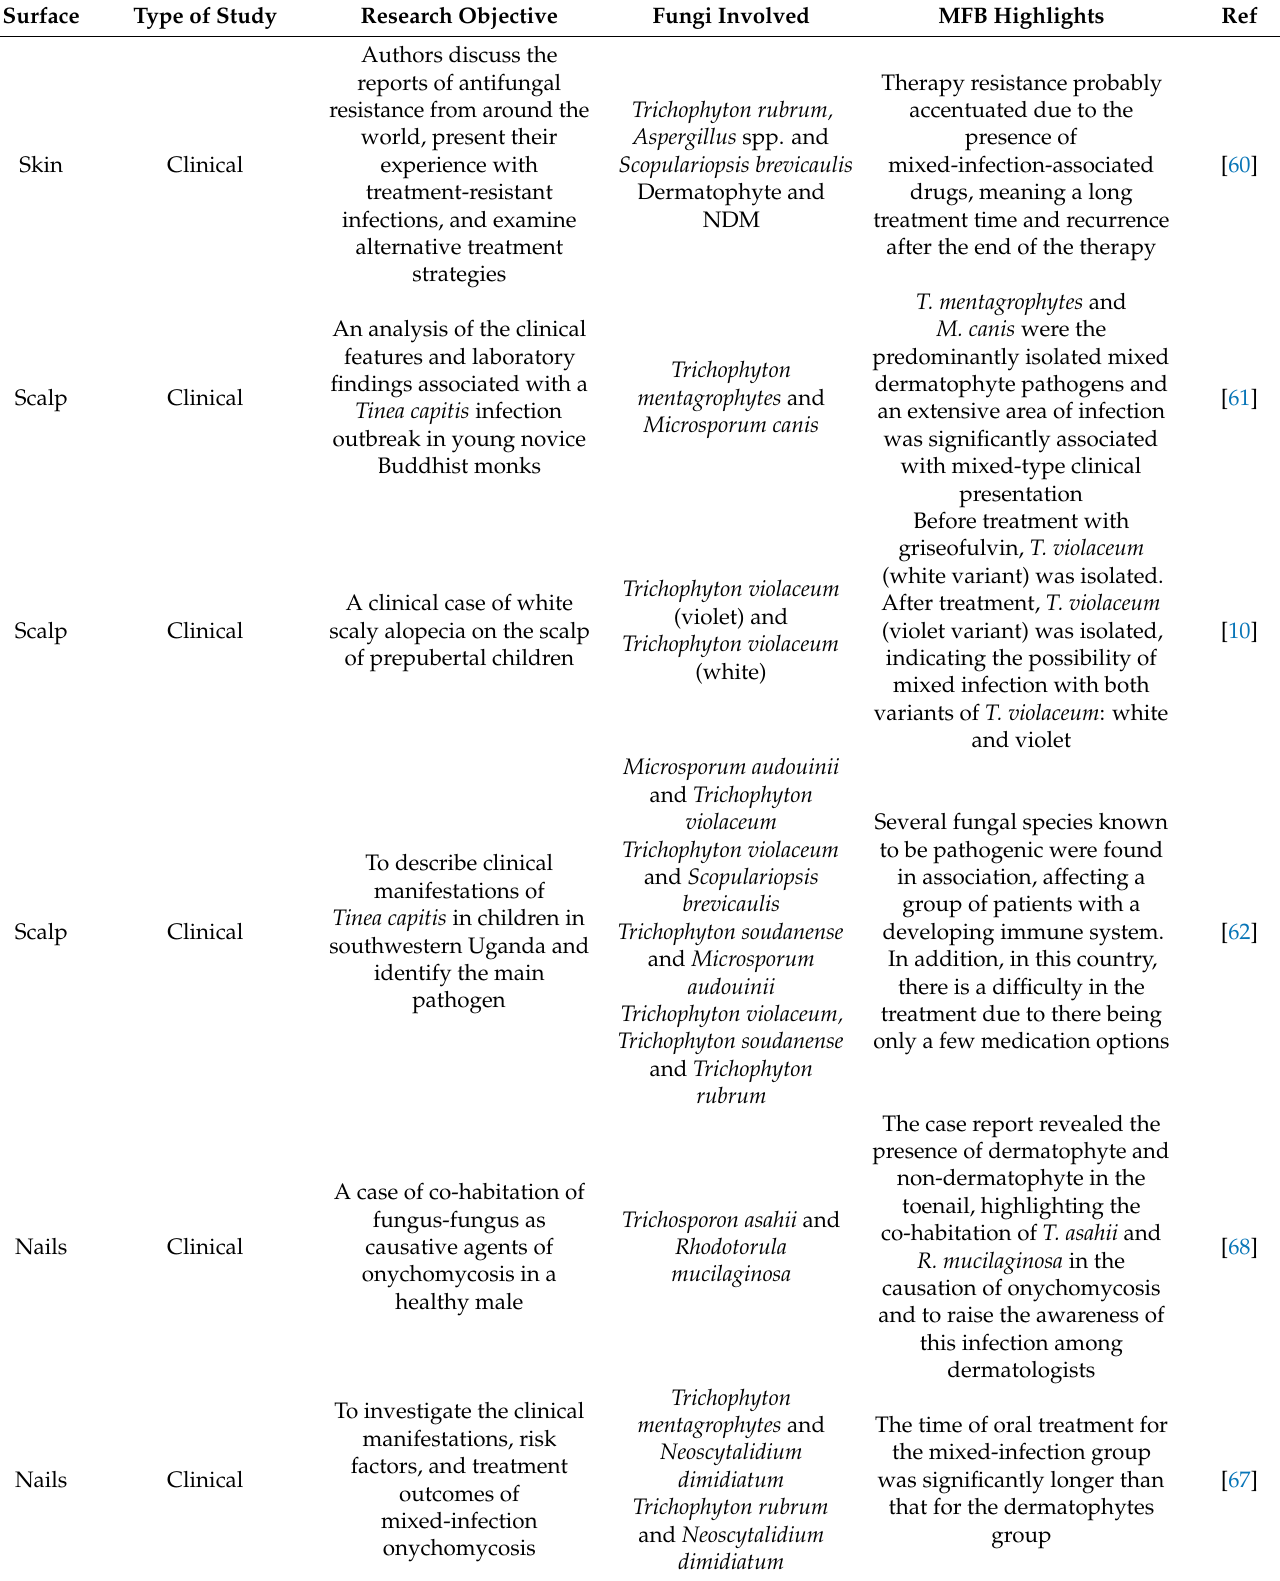
Table 1. Evidence of mixed fungal biofilm formed in biotics and abiotic